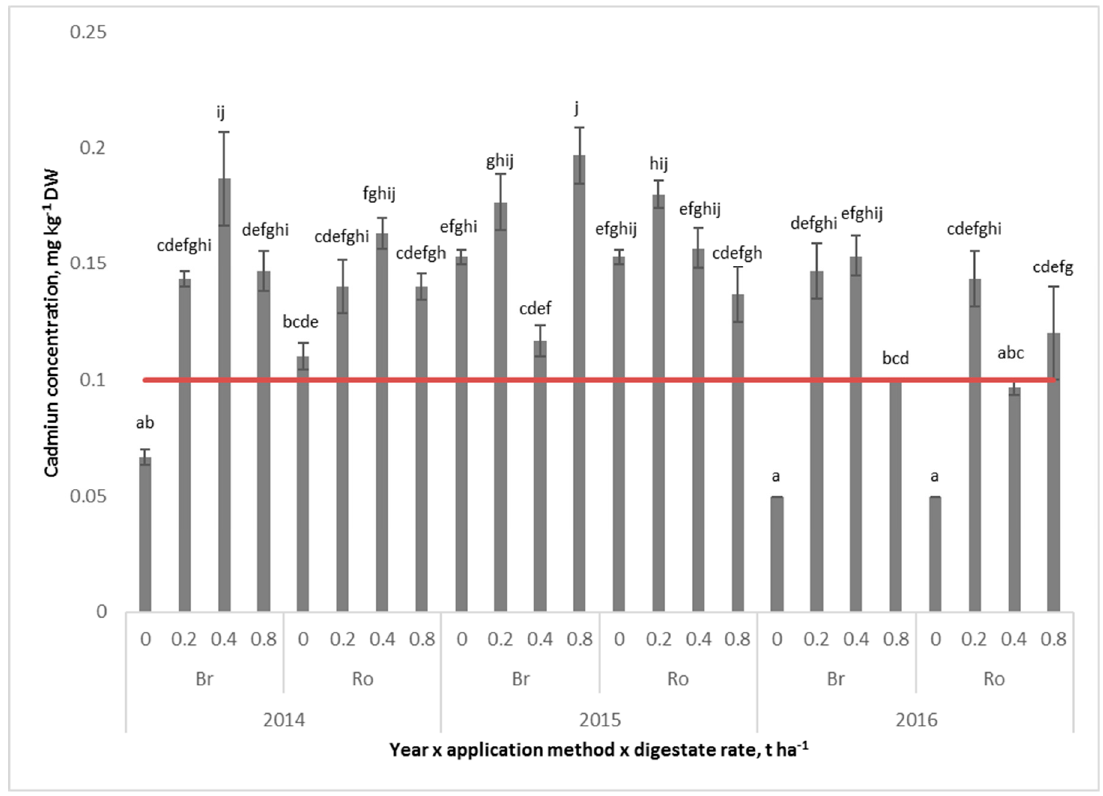
Figure 5. Effect of the method and rate of digestate on the cadmium concentration in maize grain in consecutive years on the background of the threshold Cd concentration. a Numbers marked with the same letter are not significantly different; the bars indicate a double standard error of the mean ( n = 4).